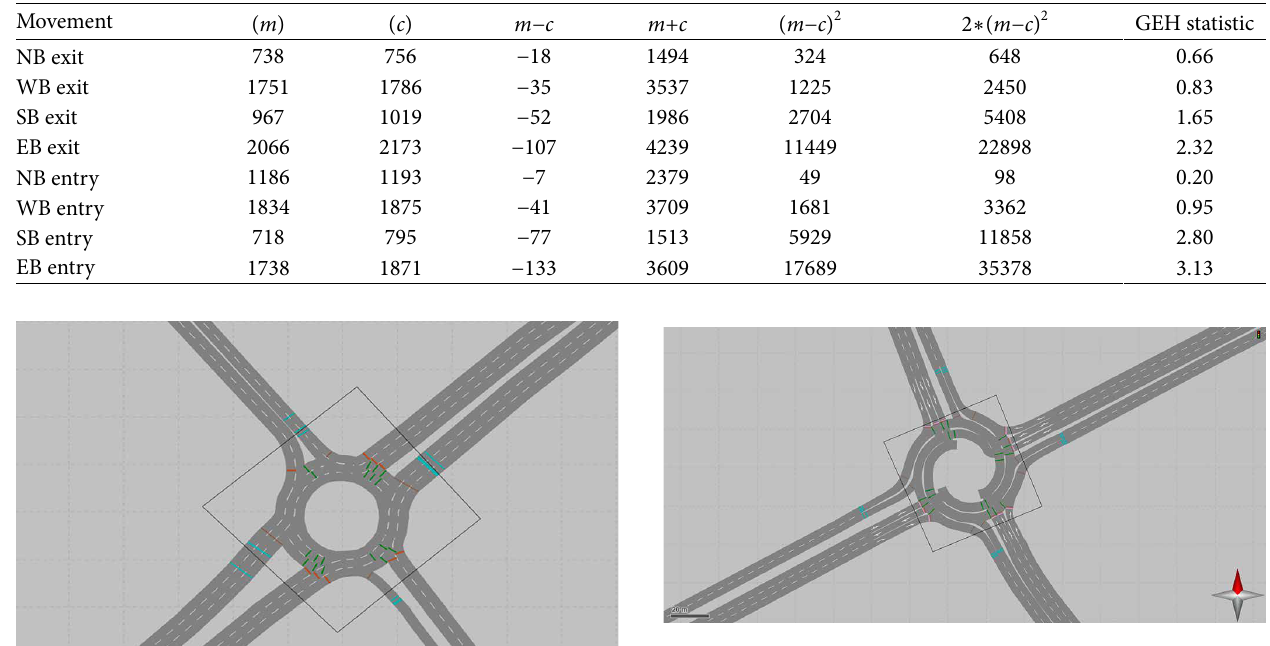
Figure 4: Layout and geometry of the proposed rotor roundabout (alternative design